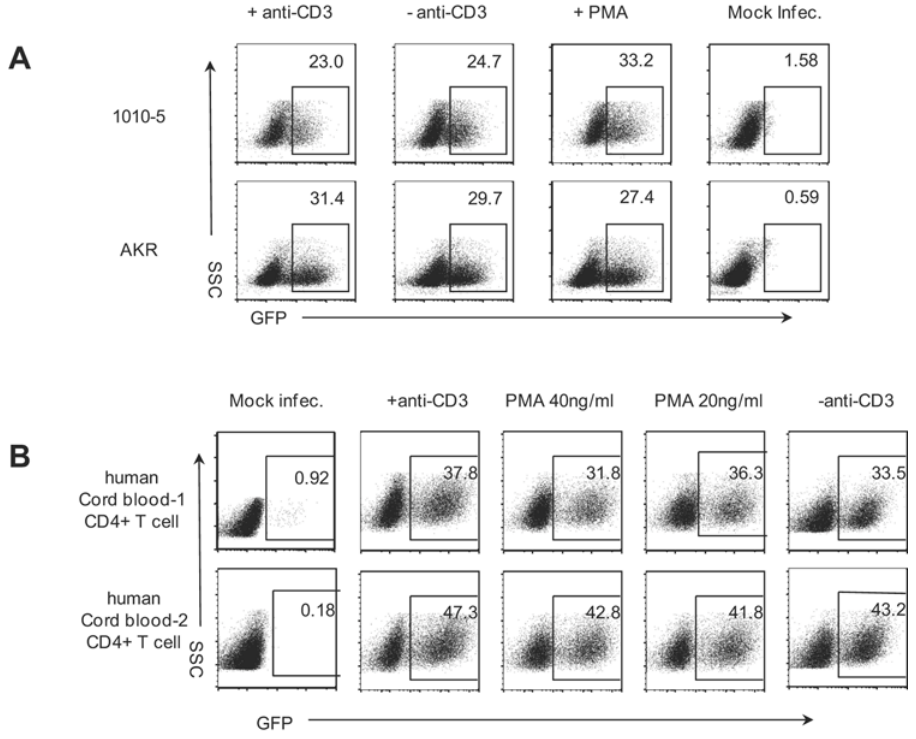
Figure 5. Role of secondary TCR signals is specific for mouse primary T cells. (A) mouse T cell lines 1010-5 and AKR were infected with HIV- CMV-GFP (VSVG) at MOI of 2. Three hours post infection, cells were transferred to wells with coated anti-CD3, no antibody, or PMA. Twenty-four hours post infection, cells were transferred to new wells with IL-2 alone. FACS analysis for GFP was done 48 h post infection. (B) CD4 + T cells from two human cord blood donors were activated with anti-CD3/28 for 36 h as described in Materials and Methods. Cells were infected and analyzed as in panel A.